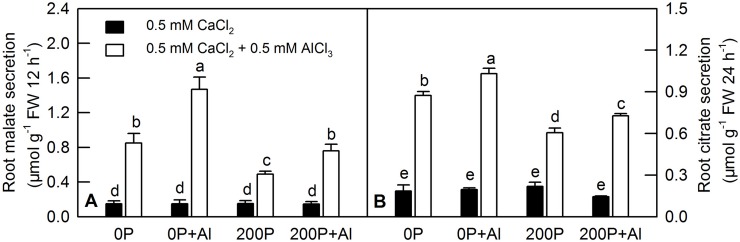
Al-induced secretion of malate and citrate in C. grandis roots.Malate (A) and citrate (B) secretion from excised roots was measured after 12 or 24 h treatment, respectively, in 0.5 mM CaCl2 + 0.5 mM AlCl3·6H2O or 0.5 mM CaCl2 solution, pH 4.1–4.2. Bars represent means ± SE (n = 4). Differences among the eight treatments were analyzed by 4 (pretreatments) × 2 (Al levels) ANOVA. Different letters indicate a significant difference at p < 0.05.